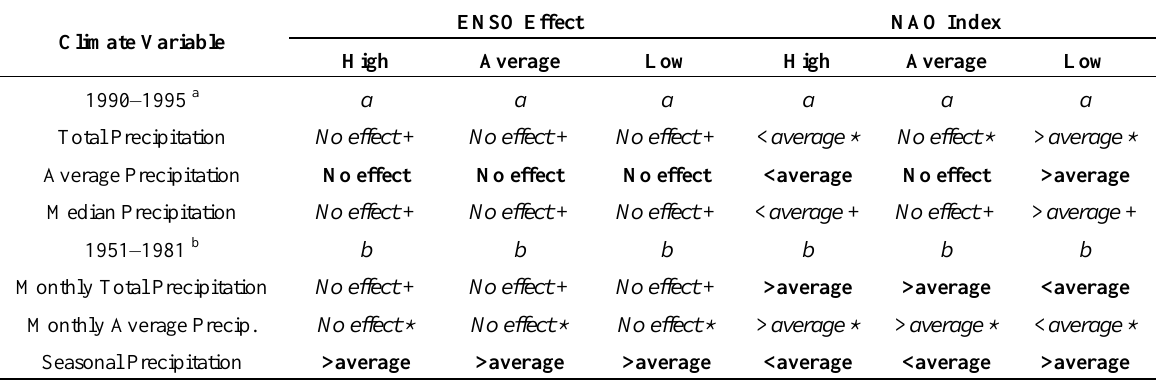
Table 2. Annual effects of El Niño Southern Oscillation (ENSO) and North Atlantic Oscillation (NAO) on Puerto Rico’s precipitation.